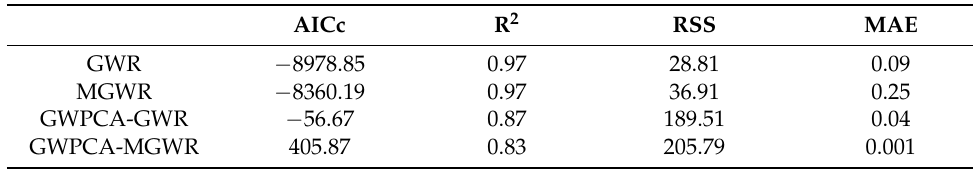
Table 2. Model index of regression models.